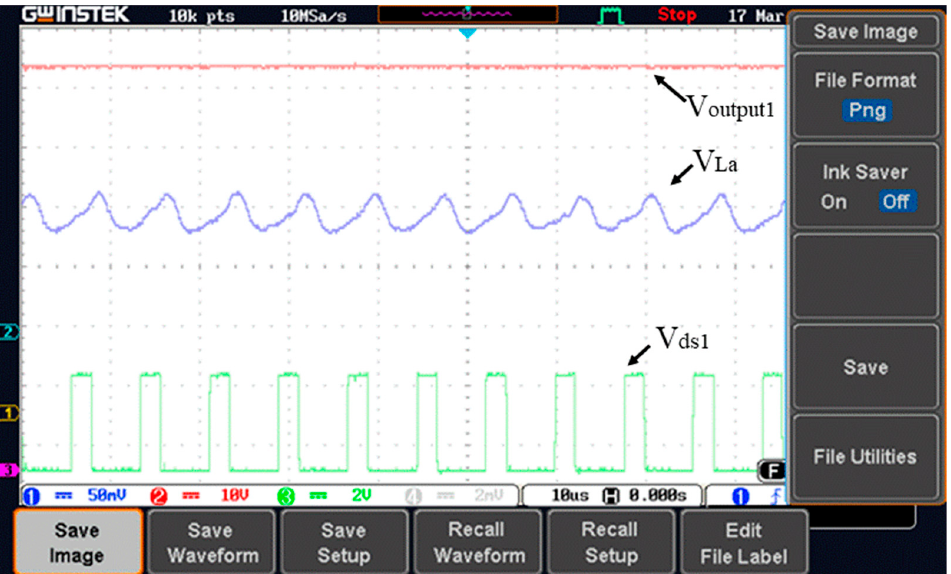
Figure 14. Switching voltage 1, inductor voltage V La , and output voltage 1 waveform.